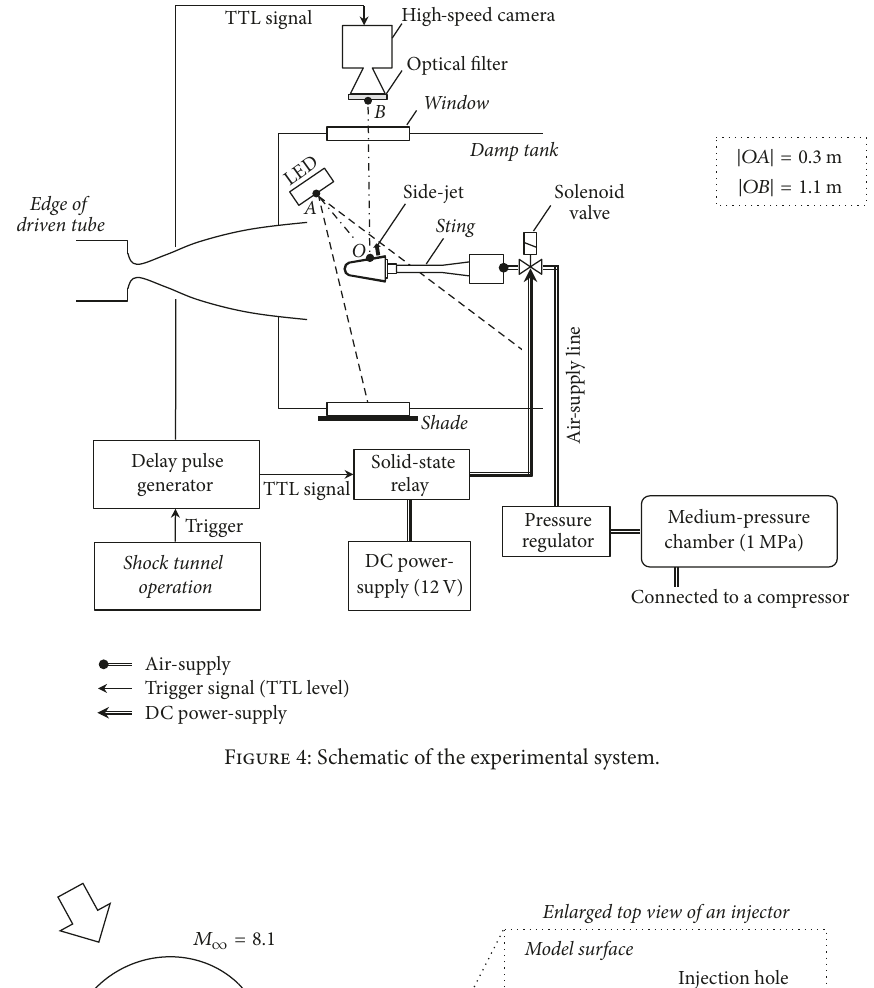
Figure 4: Schematic of the experimental system.